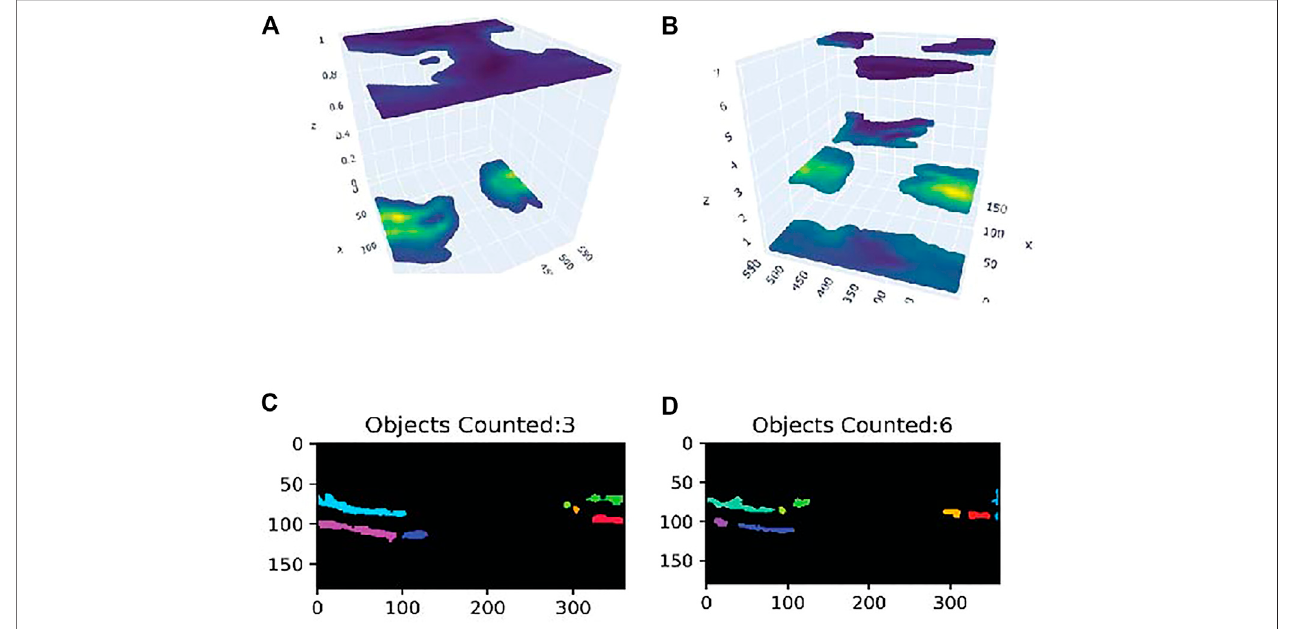
FIGURE 2 | Results of GM method application to HDR identi fi cation for a GIM on 27 October, 2002 (A) and on 19 July, 2001 (B) . Corresponding results for the image processing approach are shown in (C,D) . For 27 October, 2002, the GM method identi fi es 3 HDRs (A) , while the image processing approach identi fi es 3 HDRs (C) . For 19 July, 2001, the GM method identi fi es 5 HDRs (B) , while the image processing approach identi fi es 6 HDRs (D)